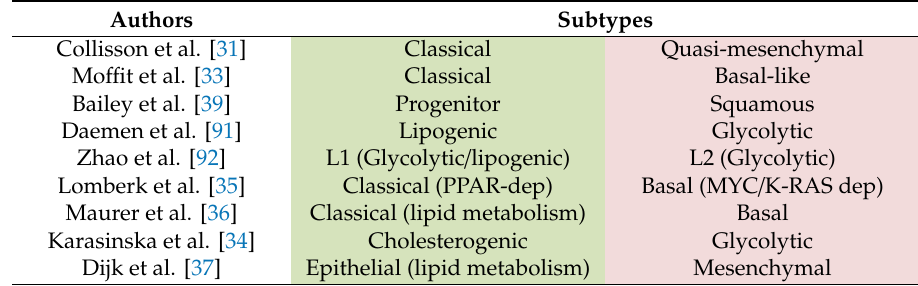
Table 4. Schematic overview of the correspondence of reported molecular and metabolic subtypes in